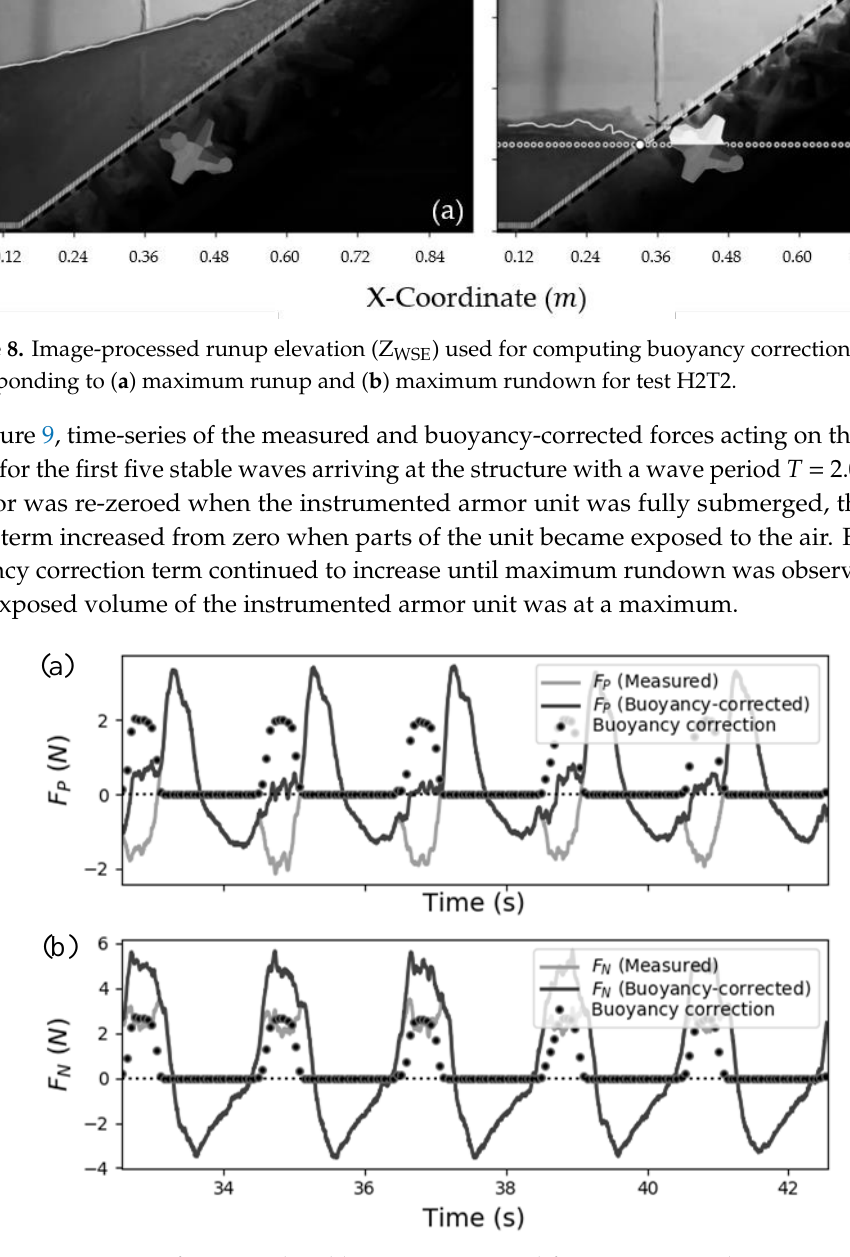
Figure 9. Time-series of measured and buoyancy-corrected forces acting on the armor unit in the ( a ) slope-parallel and ( b ) slope-normal direction for test H2T2.